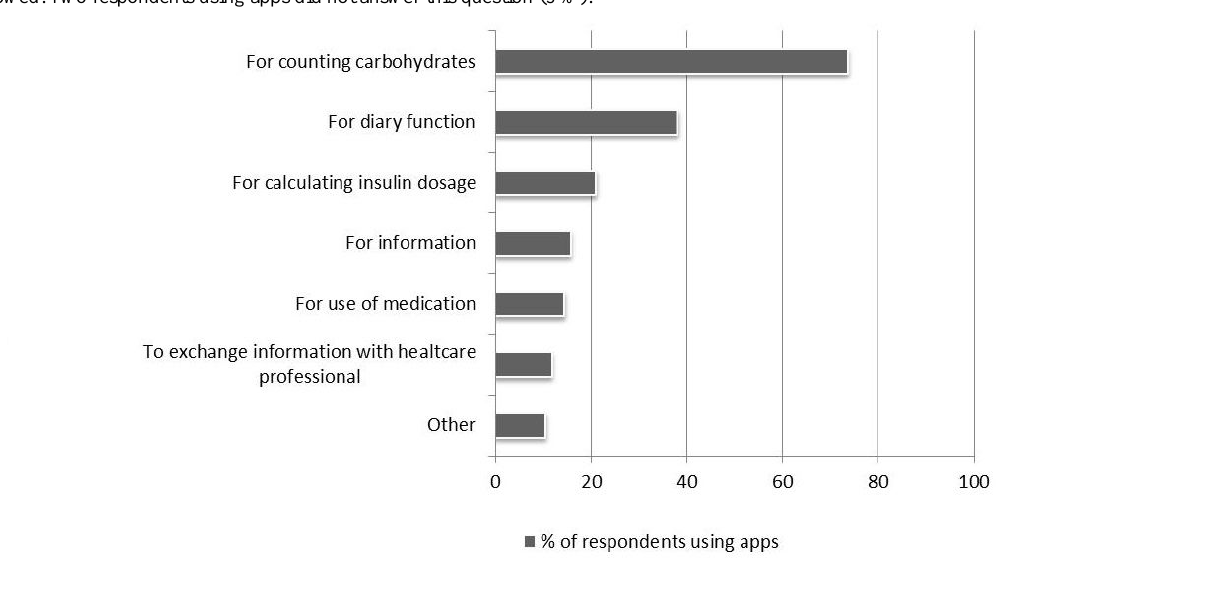
Figure 4. Types of apps used by people with diabetes. Data is presented as percentage of respondents that use apps (n = 76). Multiple answers were allowed. Two respondents using apps did not answer this question (3